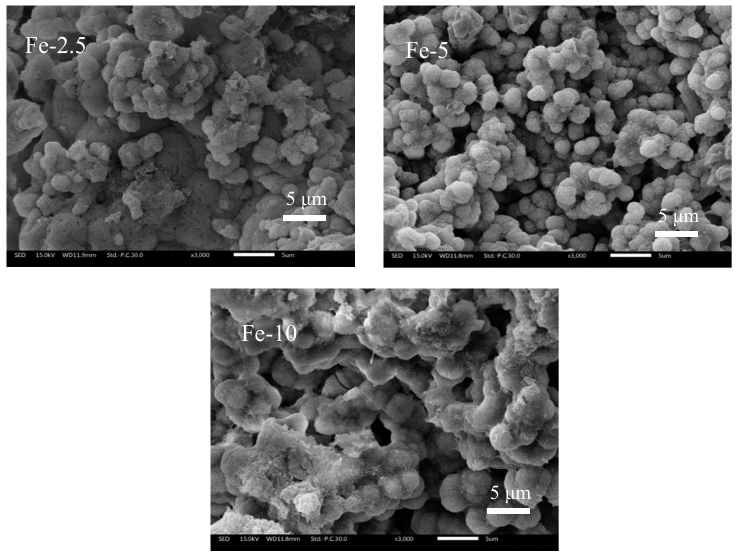
Figure 7. SEM images of Fe/C 3 Ss samples after immersing in SBF solution for seven days.